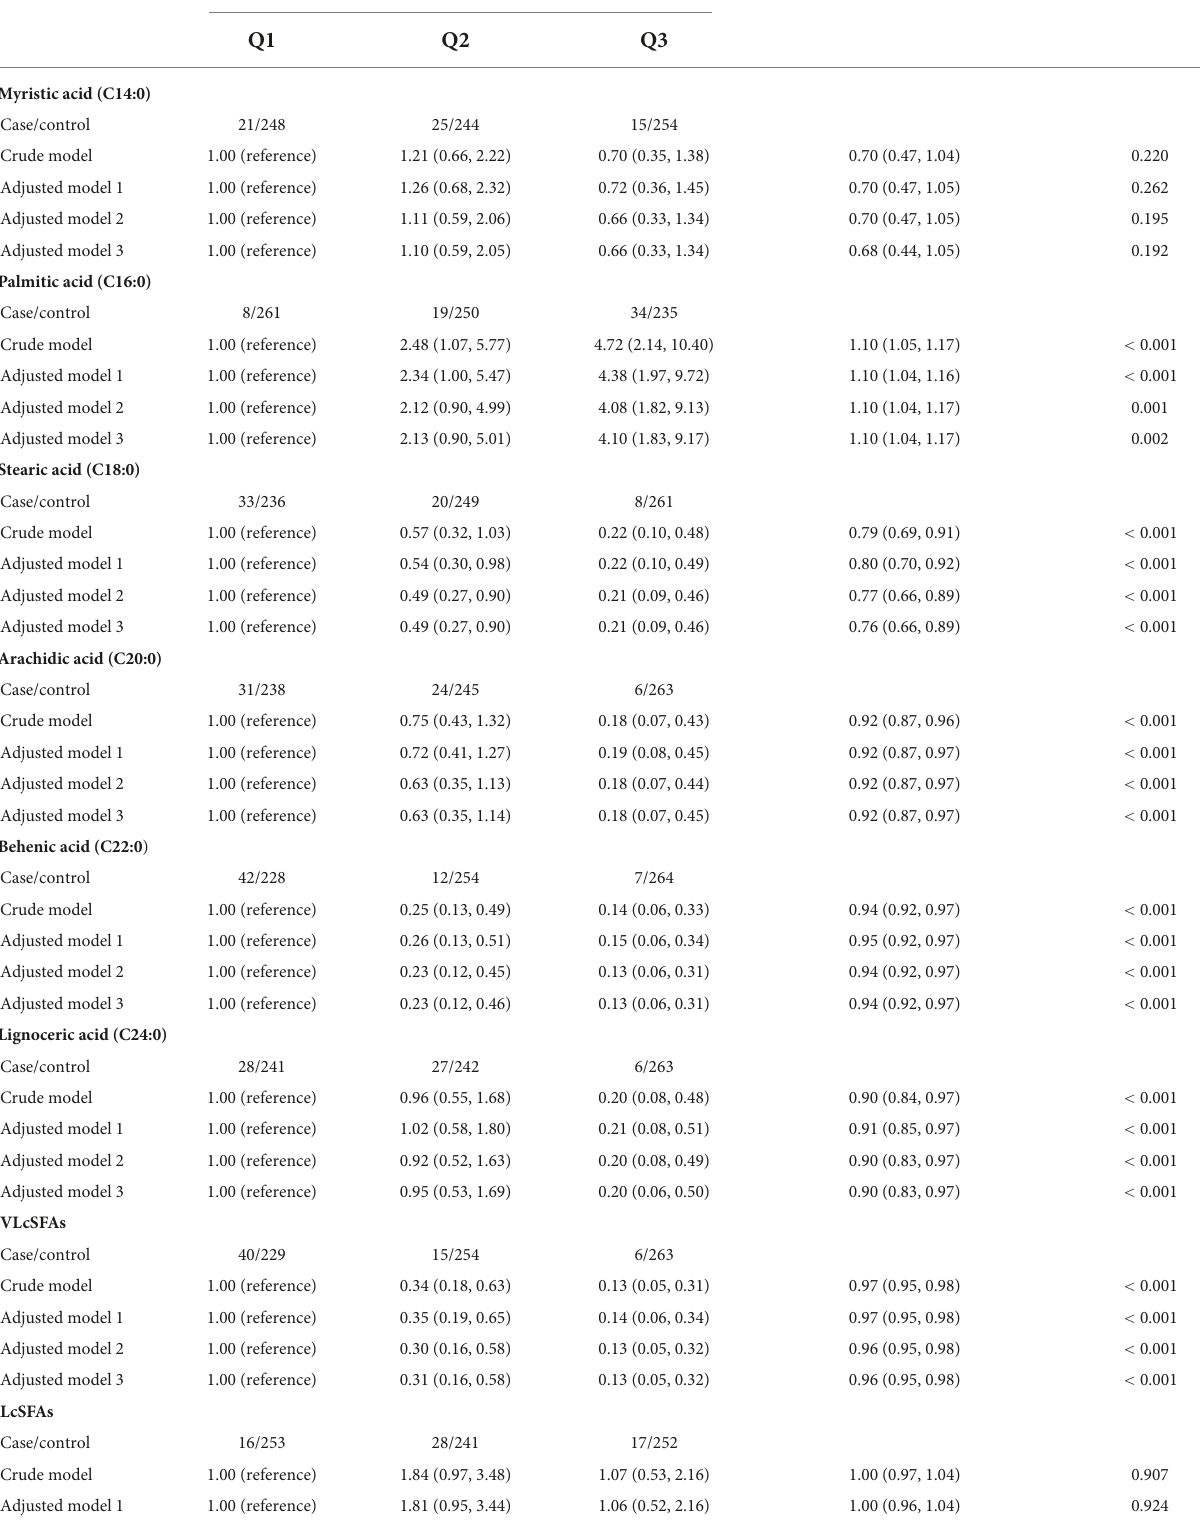
TABLE 4 Crude and adjusted ORs (95% CIs) for risk of GDM according to tertiles of plasma SFAs in the second trimesters in the cross-sectional